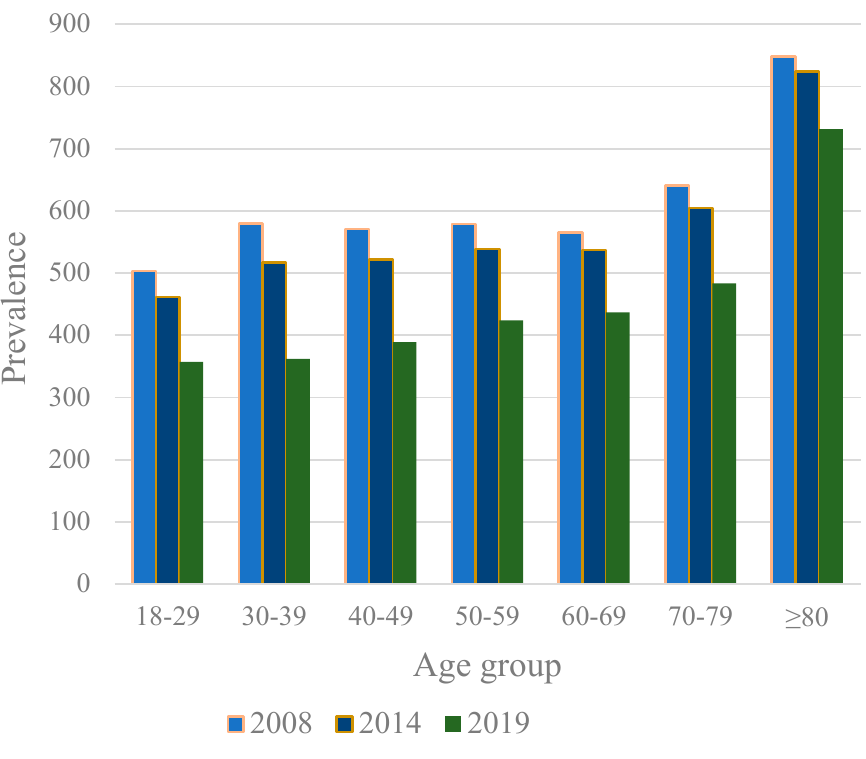
Figure 3. Antibiotic prescription rate per 1000 adults by age group at the beginning (2008), the middle (2014), and the end (2019) of the study period in Finland.